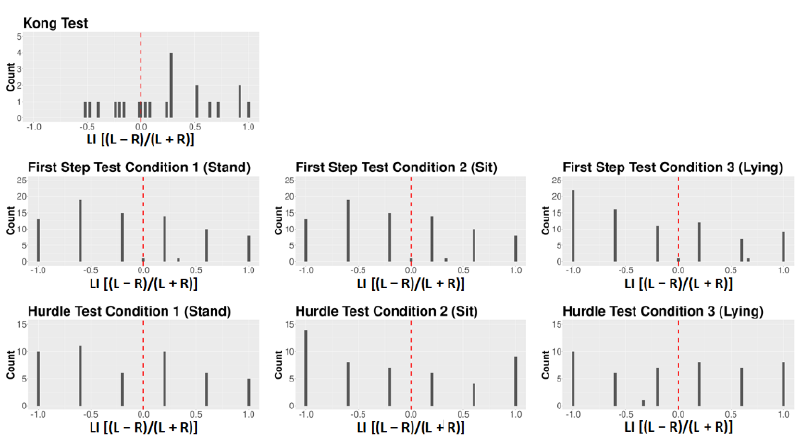
Figure A1. Frequency distribution of the dogs’ LI data for all tests and conditions.